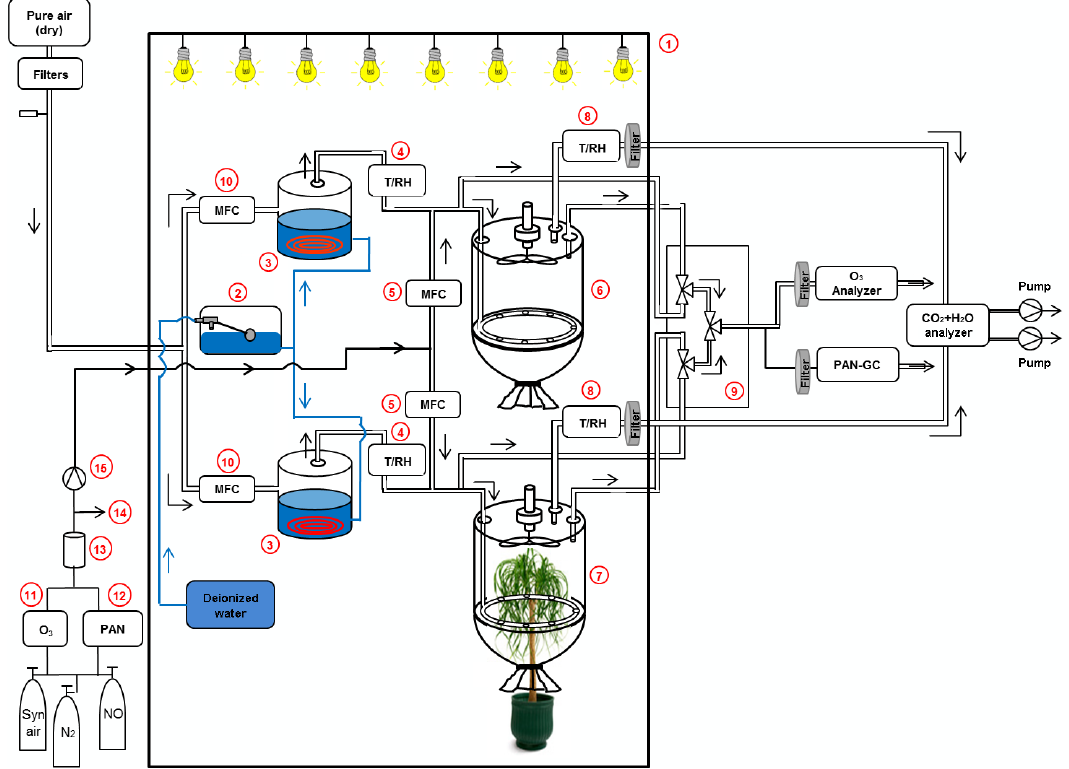
Figure 1. Flow chart of the dual cuvette system. 1 – plant cabinet; 2 – water storage tank (see Sect. 2.1.3); 3 – ATRAHS (see Sect. 2.1.3); 4 – Temperature and relative humidity sensor for humidity regulation (see Sect. 2.1.3); 5 – mass flow controller (MFC); 6 – dynamic cuvette (reference); 7 – dynamic cuvette (sample); 8 – temperature and relative humidity sensor for monitoring; 9 – Teflon-valve block; 10 –